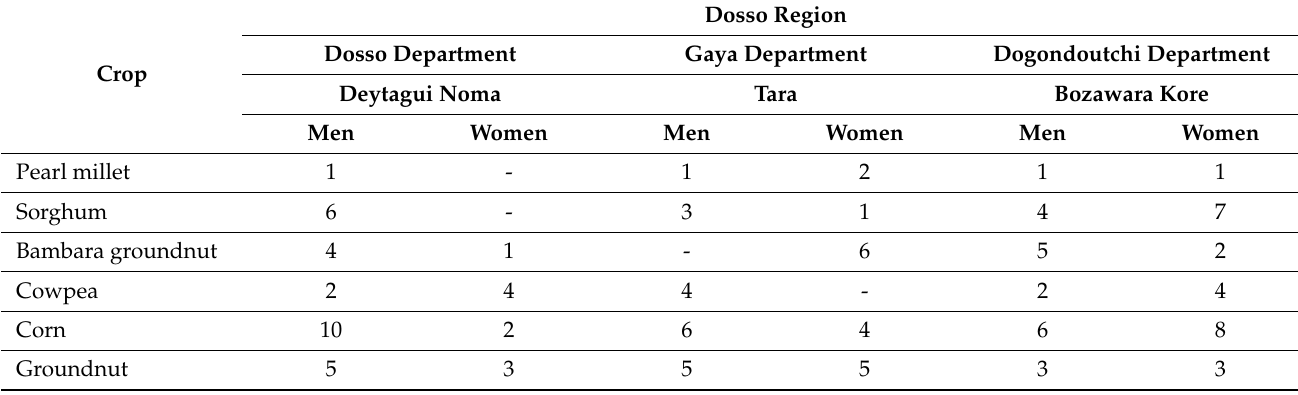
Table 1. Cultivated crops ranked according to importance to farmers in three departments (Dogondo- utchi, Dosso, and Gaya) of the Dosso region in Niger